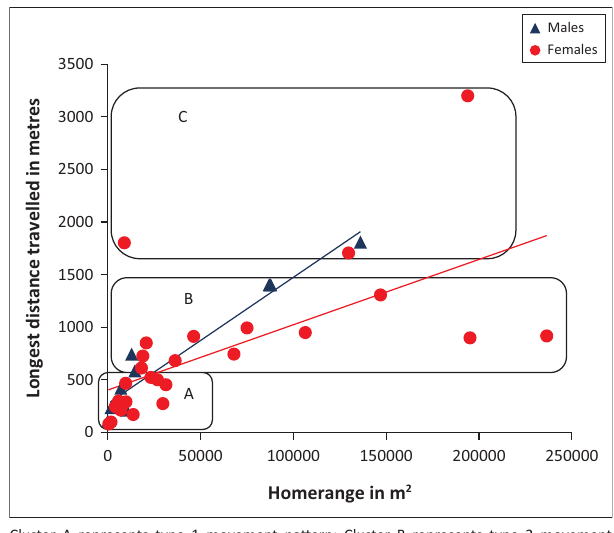
FIGURE 6: Scatter graph depicting three different movement patterns by radio- tagged tigerfish related to home range size and longest distance travelled for the study period January–December 2003.